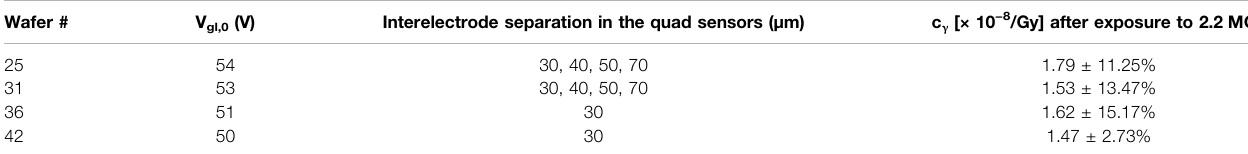
TABLE 1| Properties ofthe prototypewafers includingthe acceptor removal constants c γ ofthegainlayers, asobtainedfrom a fi tofthedatain Figure4 totheformula V gl = V gl,0 e − c ϕ after the gamma exposure reported here. The initial dopant concentrations of the gain layers (as re fl ected in the values of V gl,0 ) decrease with increasing wafer number. Wafer # V gl,0 (V) Interelectrode separation in the quad sensors ( μ m) c γ [× 10 − 8 /Gy] after exposure to 2.2 MGy